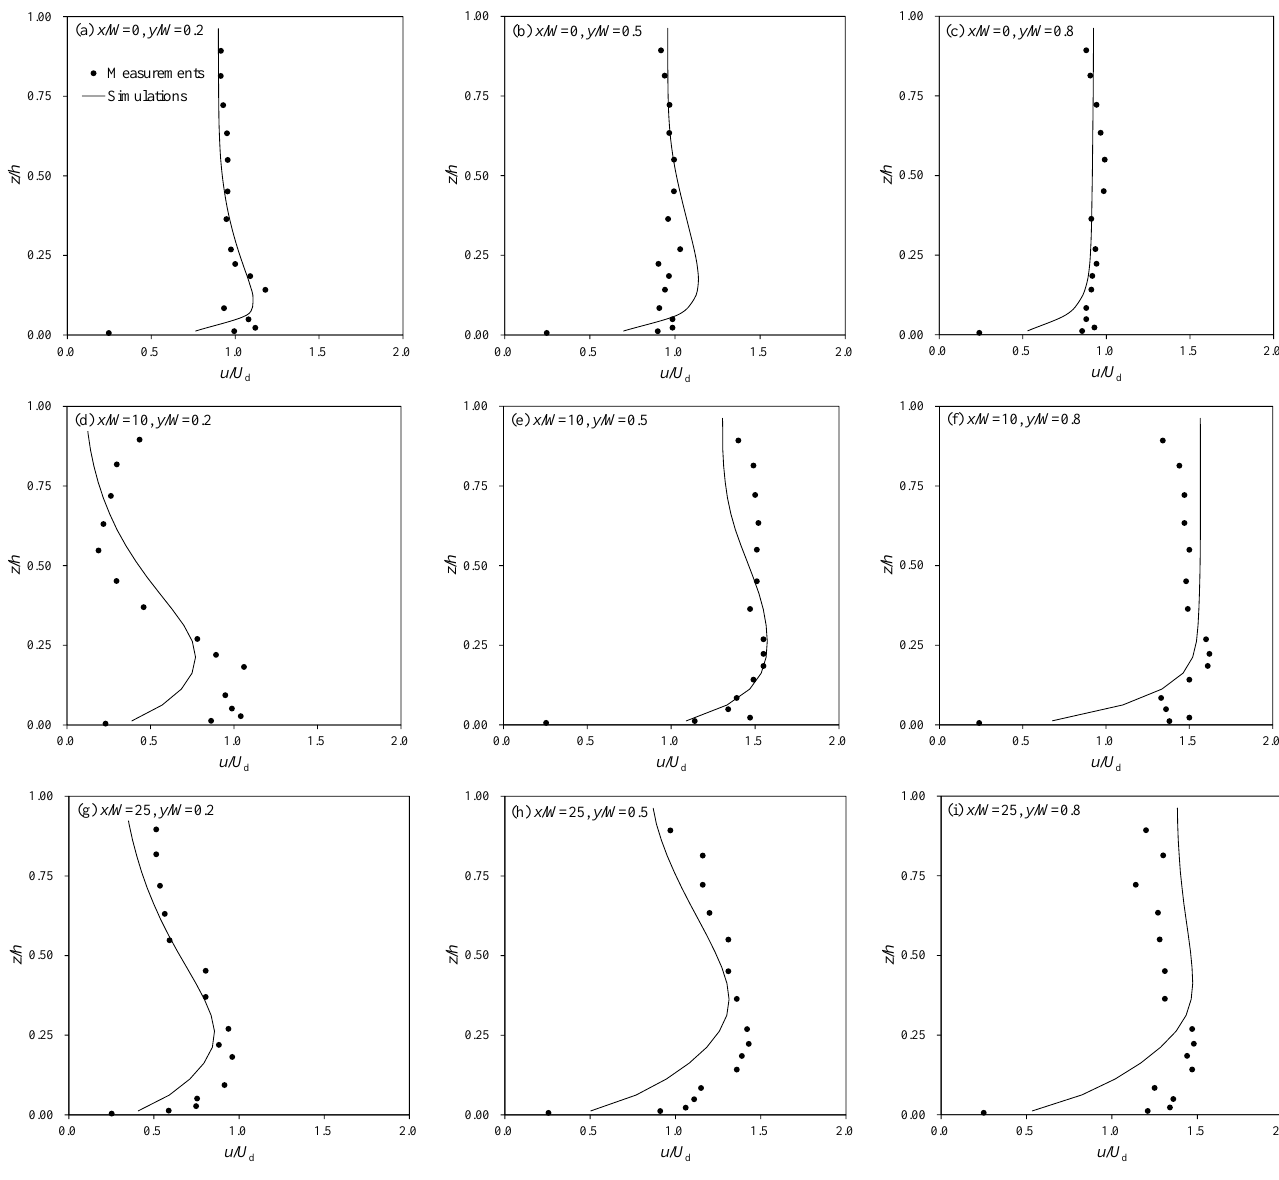
Figure 3. Comparisons of stream-wise vertical velocity profiles.